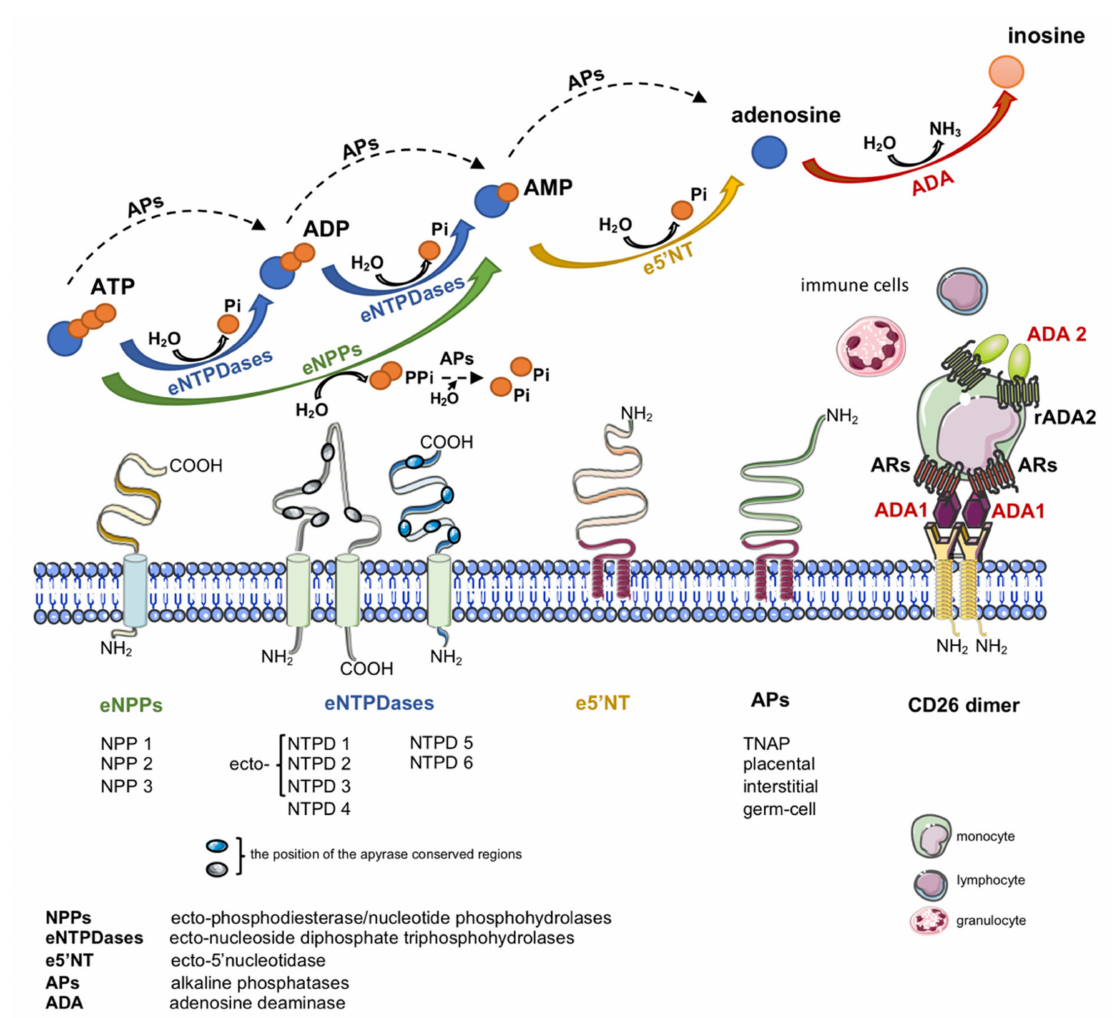
Figure 1. Enzymes engaged in extracellular metabolism of adenine nucleotides and adenosine.